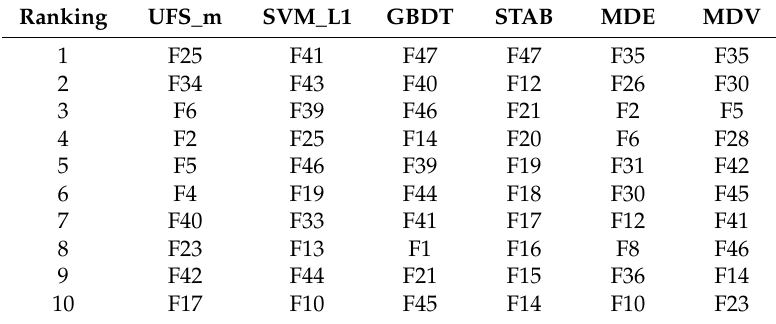
Table 5. Top 10 ranking